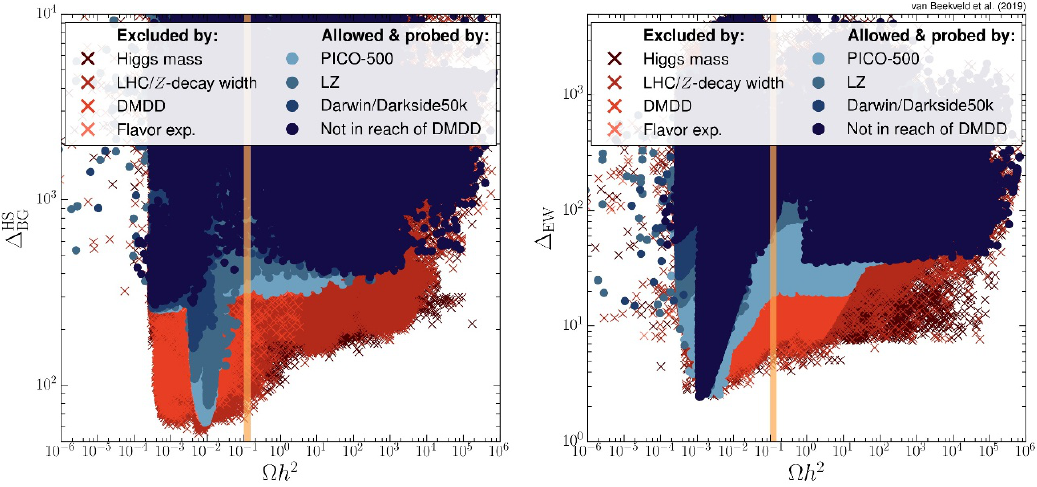
Figure 11 . Generated spectra for the pMSSM-GUT model. The left (cid:12)gure shows (cid:1) HS function of (cid:10) h 2 , the right (cid:12)gure shows (cid:1) EW as a function of (cid:10) h 2 . The color code and plotting order is the same as in (cid:12)gure 1. The orange band indicates (cid:10) h 2 = 0 : 12.